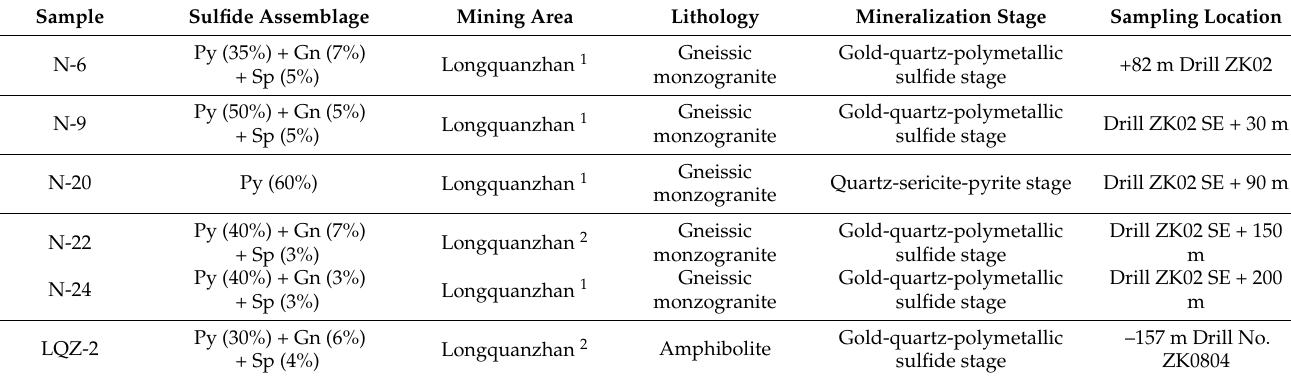
Table 1. Sampling locations of ores from the Longquanzhan, Yi’nan, and Qibaoshan gold deposits. Sample Sulfide Assemblage Mining